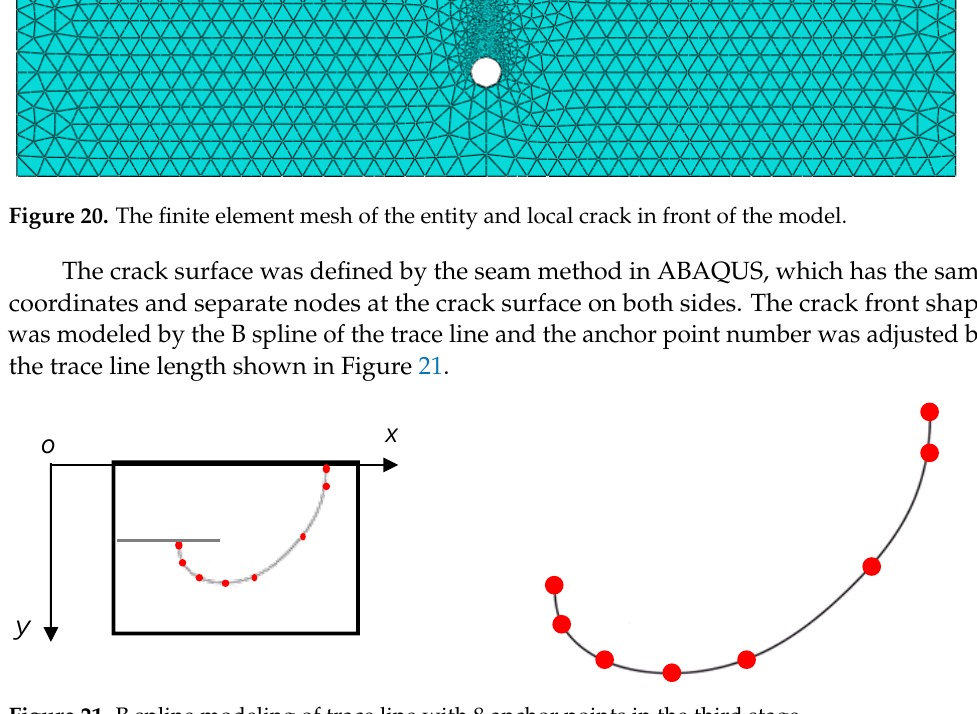
Figure 21. B spline modeling of trace line with 8 anchor points in the third stage.